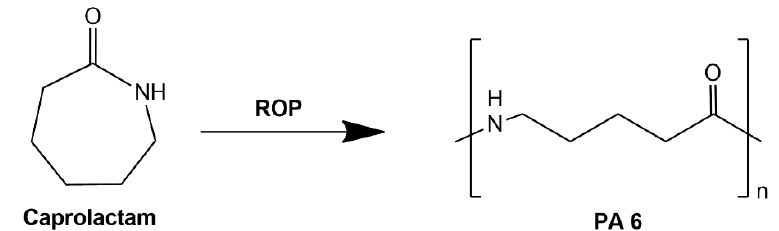
Figure 1. The reaction scheme for obtaining polyamide 6 from caprolactam.